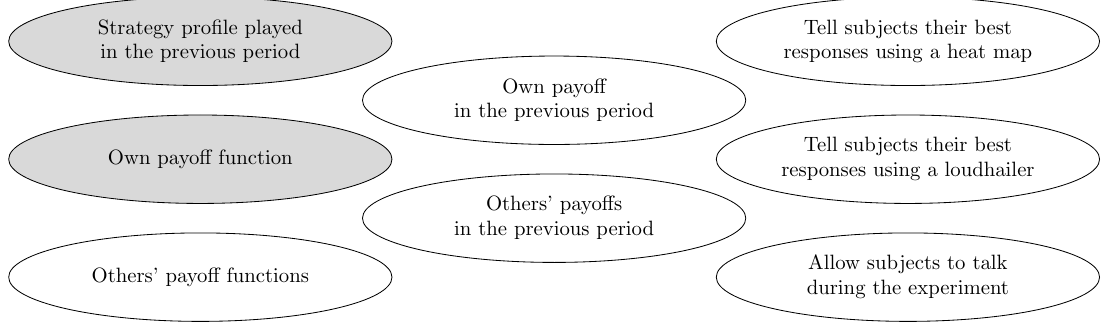
Figure 17. Information and context in an experiment. If only the shaded elements pertain, this is sufficient to make it possible that players follow an individualistic best response dynamic. However, all of the elements are compatible with players following such a dynamic, so there is nothing wrong with including any of them in a situational context that is being explored. Some of the elements, such as telling subjects individual best responses, might be expected to work towards inducing such a dynamic, whereas others, such as allowing subjects to talk, might be expected to work against it and in favor of some other dynamic such as coalitional best